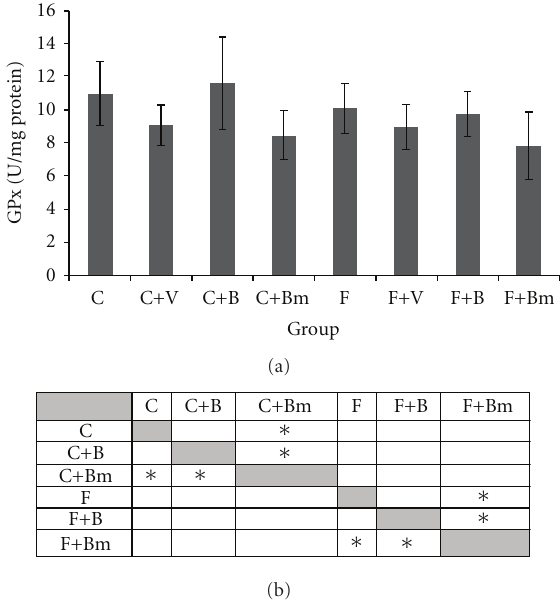
Figure 7: E ff ects of vanadium complex V, B, and Bm on plasma GPx activity of Wistar rats. Data are presented as mean ± SD for n = 6. (b) Statistical di ff erences between groups P < 0.05.